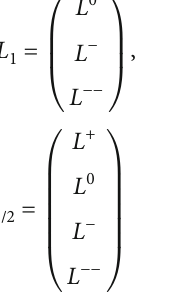
= 1 multiplet for f = 1 and Λ = M for various ep 1 W L